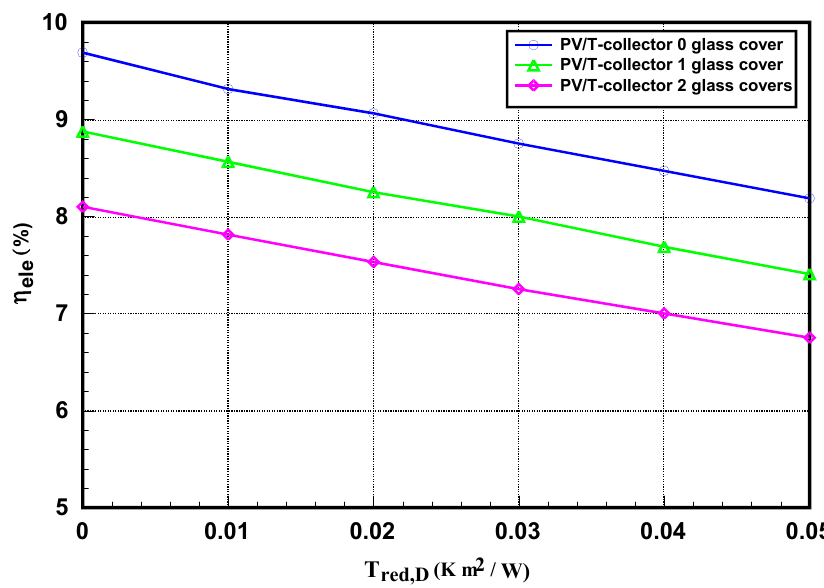
Figure 12. Electrical efficiency against reduced temperature for various designs.